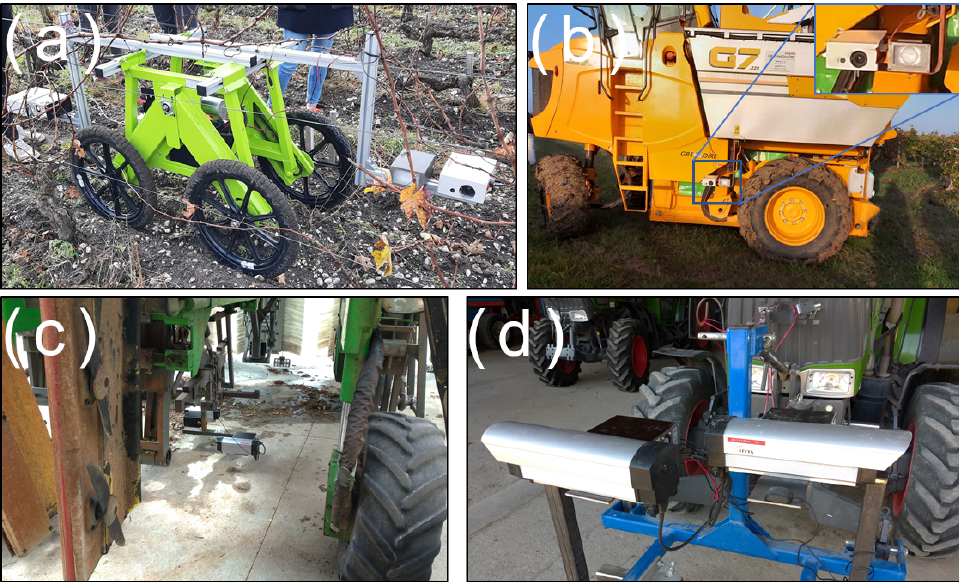
Figure 3. Photos of the sensor mounted on different vehicles. ( a ) Mounted on a small electric robot; ( b ) mounted on a harvesting machine; ( c ) mounted under a straddle tractor; ( d ) mounted on a